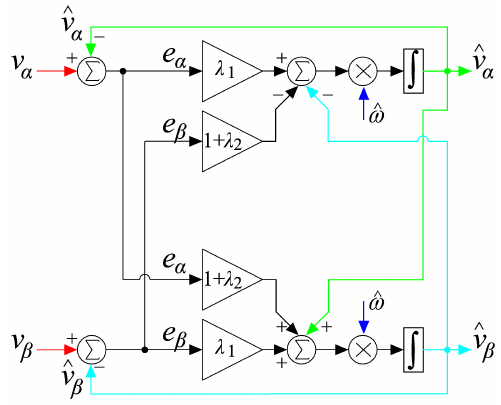
Figure 2. Block diagram of the proposed enhanced reduced-order generalized